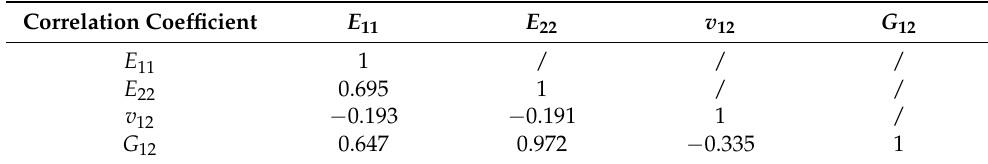
Table 19. Correlation coefficients between the stiffness properties of H-GFRPs under the ETW